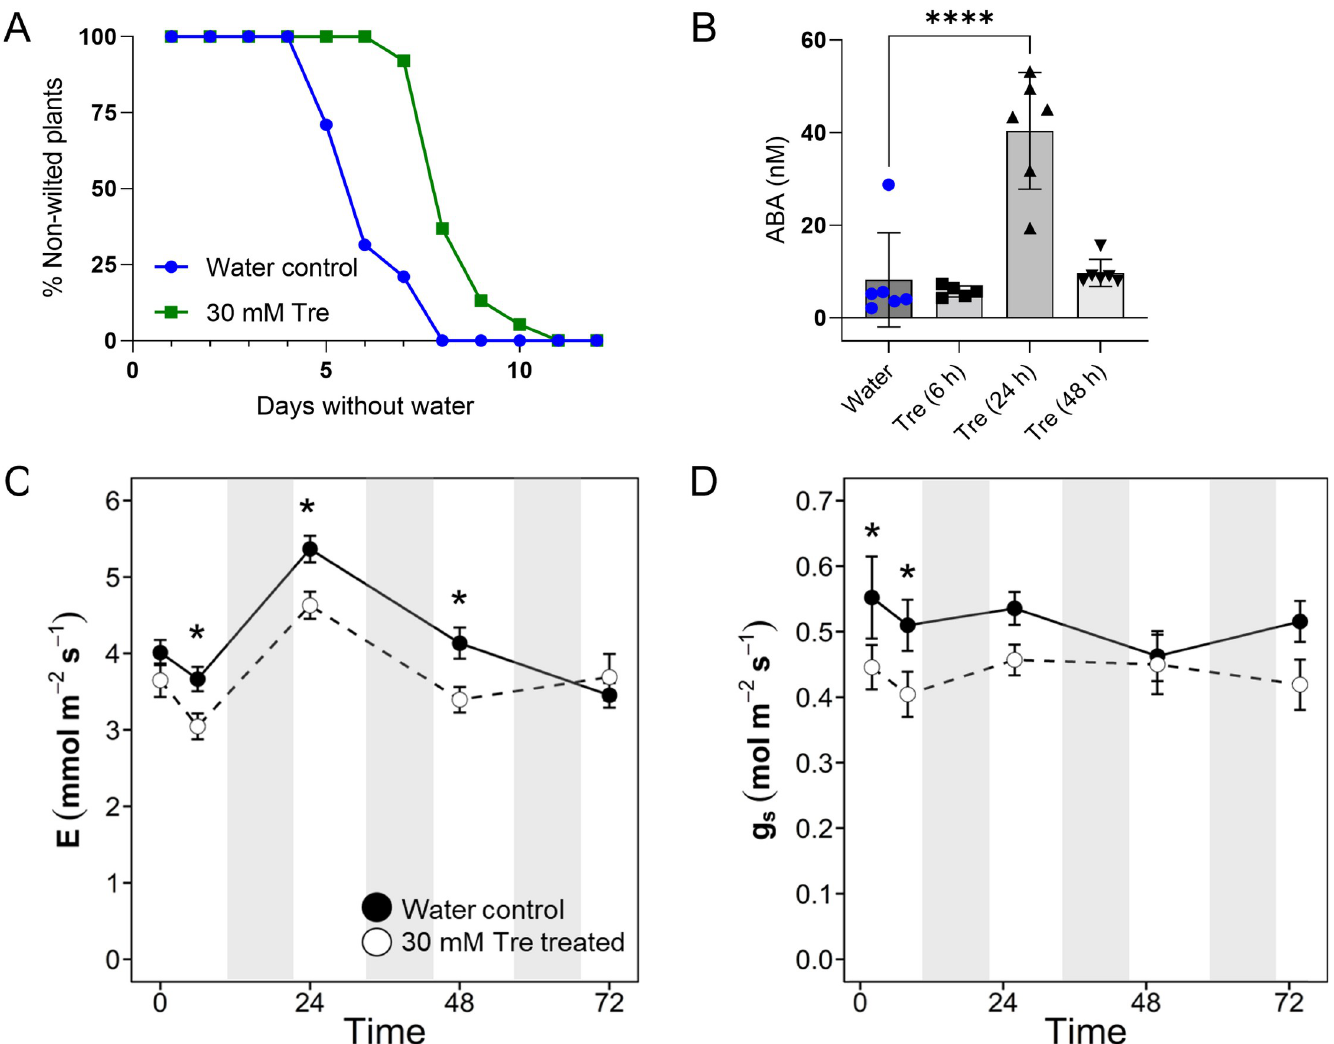
Fig 3. Trehalose treatment delayed tomato wilting due to drought, likely by transiently increasing ABA content in xylem sap and by decreasing stomatal conductance and transpiration. A) Curves show how long it took plants to wilt following a single treatment with either water (blue) or 30 mM trehalose (green) and then no water for two weeks ( P = .01, T-test of areas under the curve). Data shown represent four biological replicates totaling 38 plants per treatment. B) ABA concentration in trehalose treated plants (one-way ANOVA Fisher’s LSD multiple comparisons to water-treated control: 6 h tre P = .63; 24 h tre P < .0001; 48 h tre P = .76). Water controls were collected concurrently with the treated samples and averaged. Data shown represent xylem sap samples from six plants. C) Transpiration and D) stomatal conductance were measured with LI-COR. Asterisks indicate P > .05, mixed-model ANOVA, Tukey’s HSD. Data shown represent 20 plants/treatment. Measurements were taken 10 min after treatment with trehalose or water, then each day after that in the morning two hours after growth chamber lights went on. Shaded gray vertical bars on the graphs represent night periods. Bars on the data points represent the standard deviation. All data were calculated from the same LICOR time